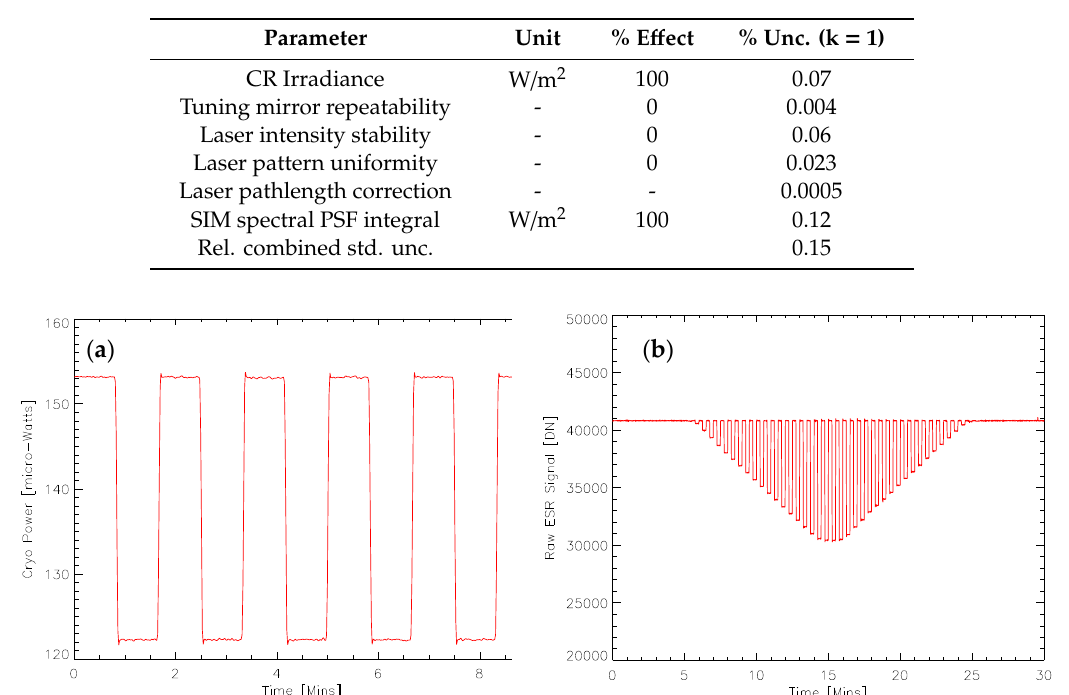
Table 8. SRF end-to-end uncertainty budget in irradiance (W / m 2 ).